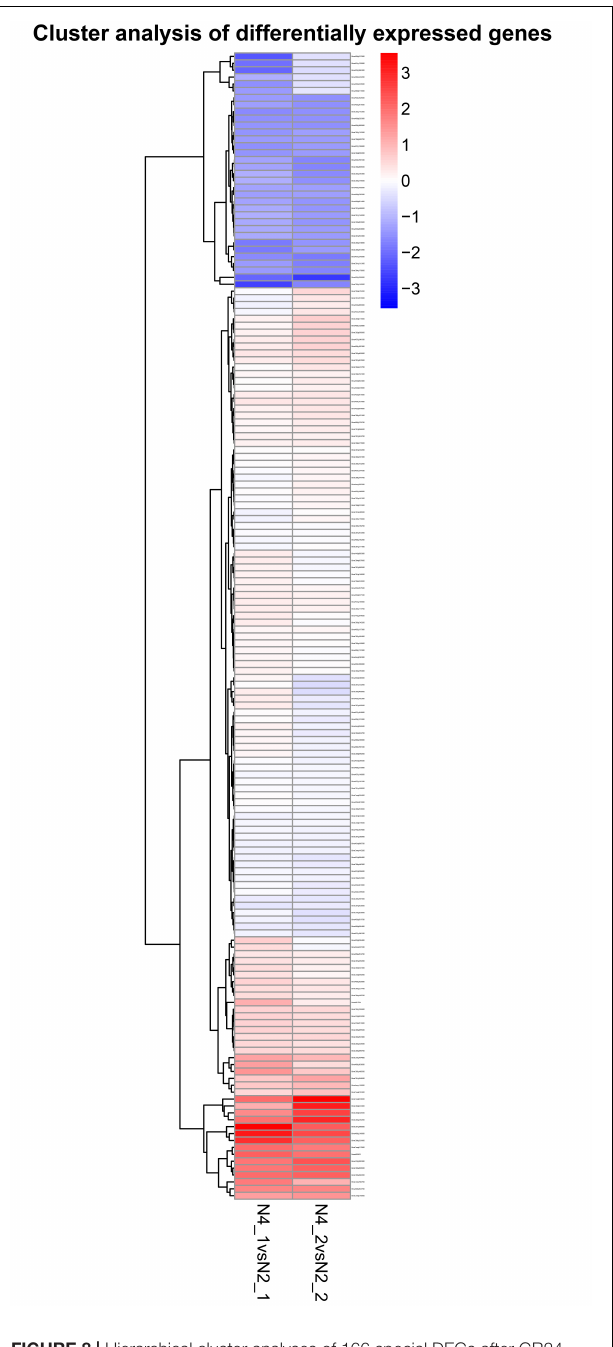
FIGURE 8 | Hierarchical cluster analyses of 166 special DEGs after GR24 treatment under salinity stress. This map shows the genes of log 2 (foldchange) values of GR24 effects on shoot and root. The “N4_1 vs N2_1” indicates a comparison between the gene expression in the N4_1 library with that in the N2_1 library, and the same describes as “N4_2 vs N2_2.”